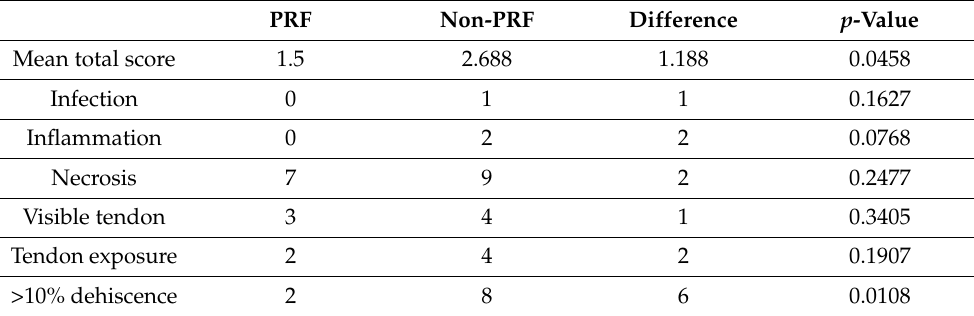
Table 5. Detailed comparison of the evaluation scores in the PRF and non-PRF